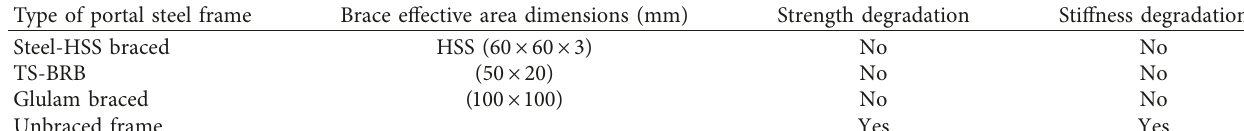
Table 6: Strength and stiffness degradation of braced and unbraced portal frames.